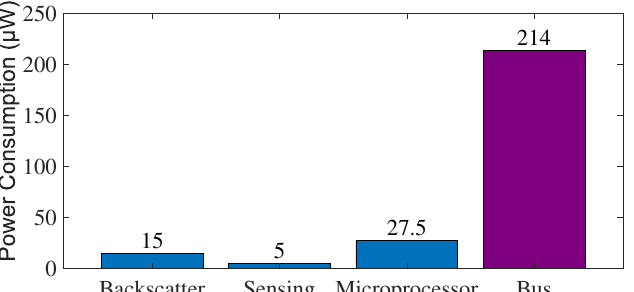
Figure 3. The power consumption comparison of typical components and functions on backscatter sensors, including the backscatter communication, sensors, processor functions (simplified using the R2B technique) and bus